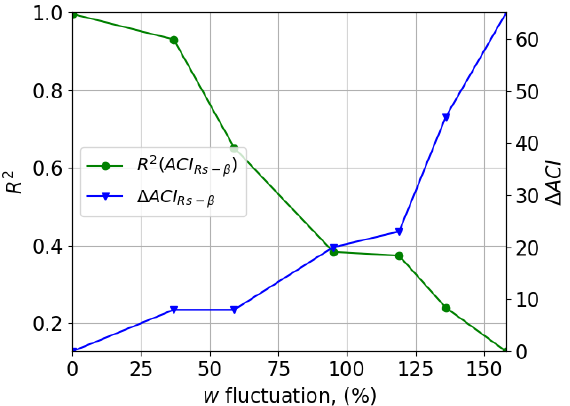
Figure A6. R 2 (left axis) and ∆ ACI (right axis) with respect to the w uncertainty. R 2 N d − AOD and ∆ ACIref f − AOD (not shown) are identical to R 2 N of w only affect within the